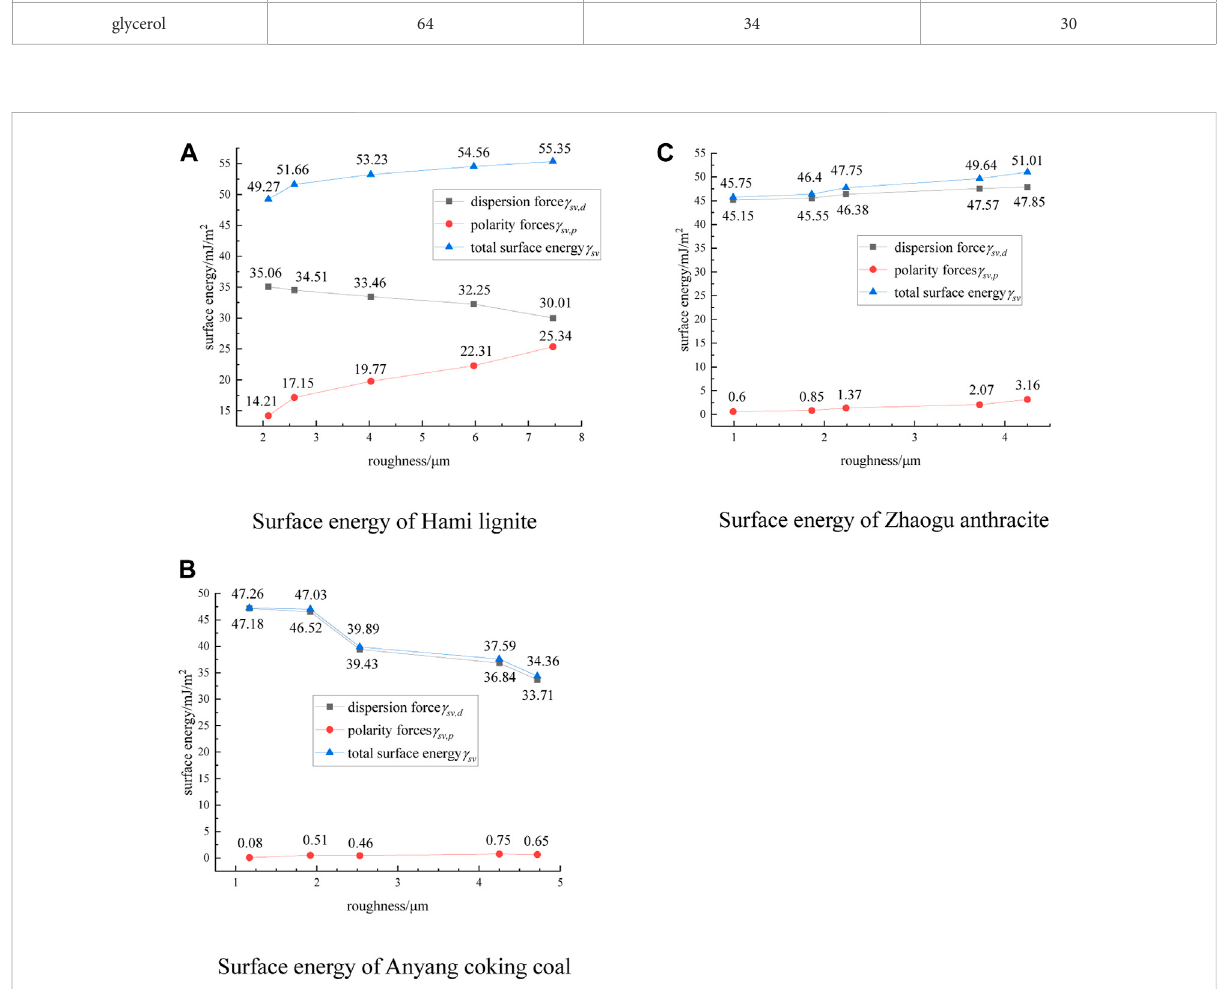
FIGURE 6 Surface energy of three coal samples (A) Hami lignite, (B) Anyang coking coal, (C) Zhaogu